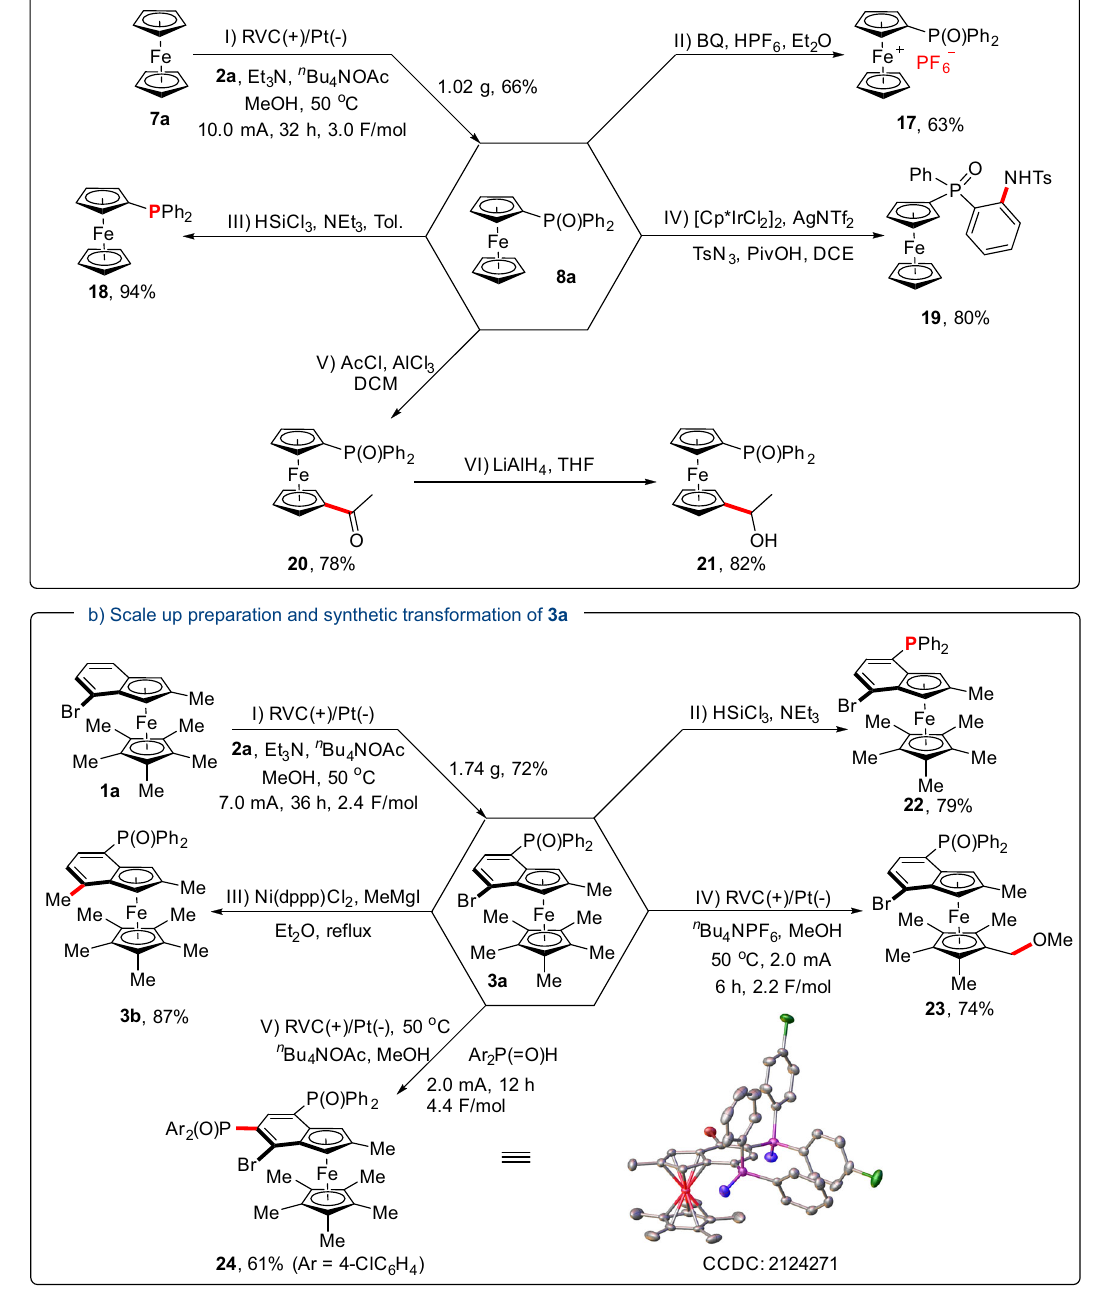
Fig. 6 Scale-up preparations and synthetic transformations. a Scale-up preparation and synthetic transformation of 8a . b Scale-up preparation and synthetic transformation of 3a